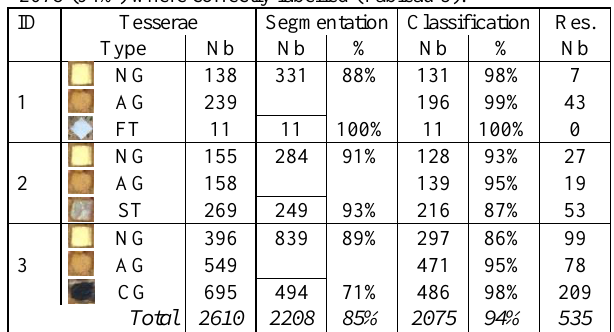
Tableau 3 Recapitulative of tesserae detection results